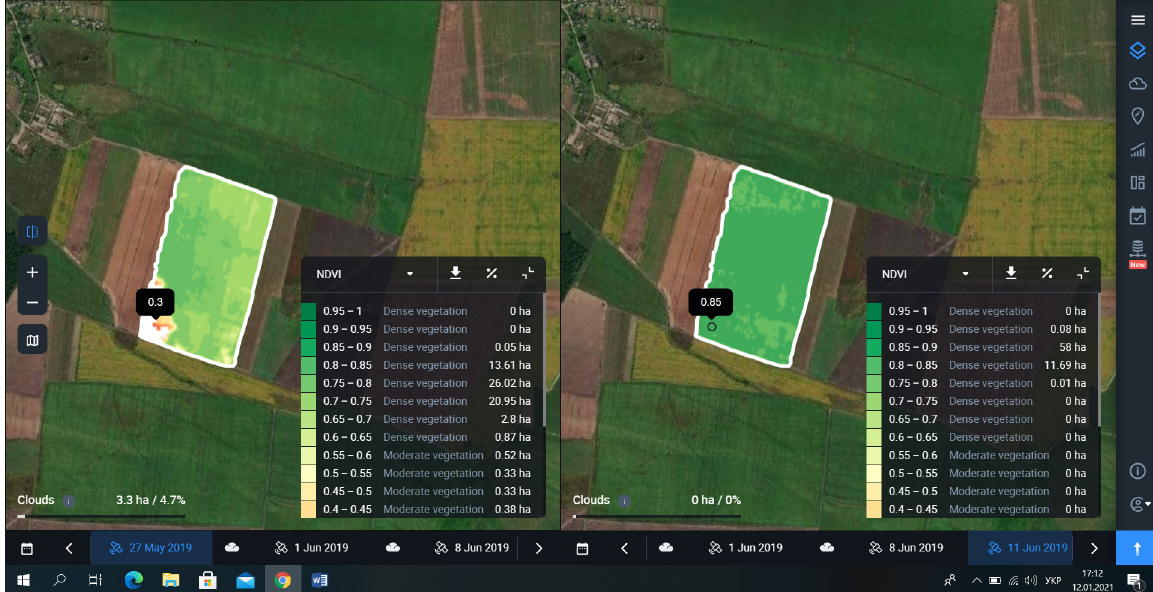
Figure 8. Comparison of the state of the neighboring area for research object of land use on the vegetation index NDVI on May 27 and June 11,